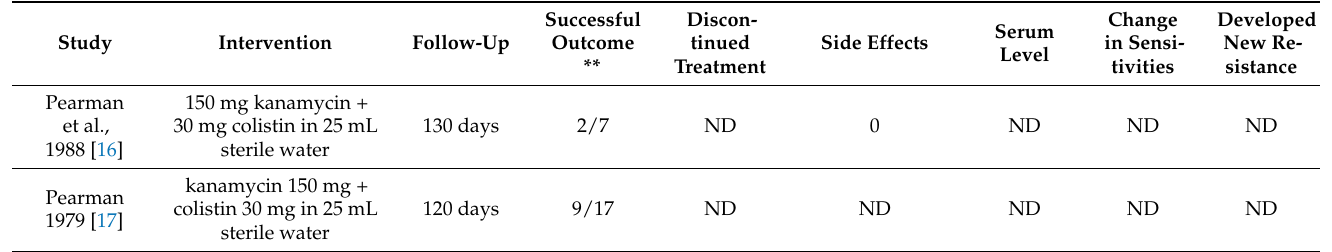
Table 4. Administration, outcomes, and safety of use of an intravesical aminoglycoside in combination with polymyxin for